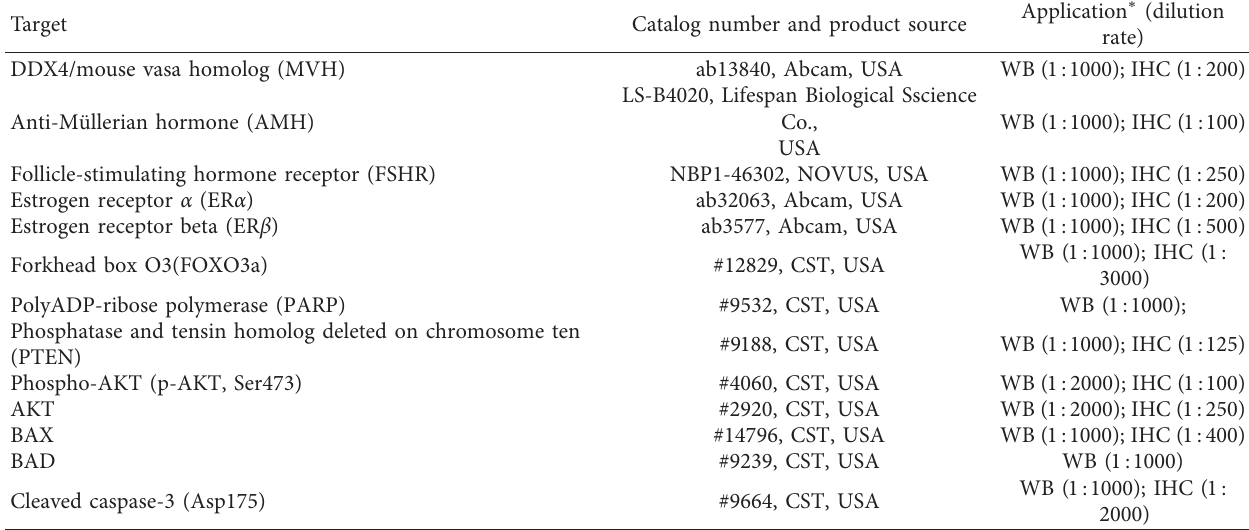
Table 1: The product information of the primary antibodies used in this study.